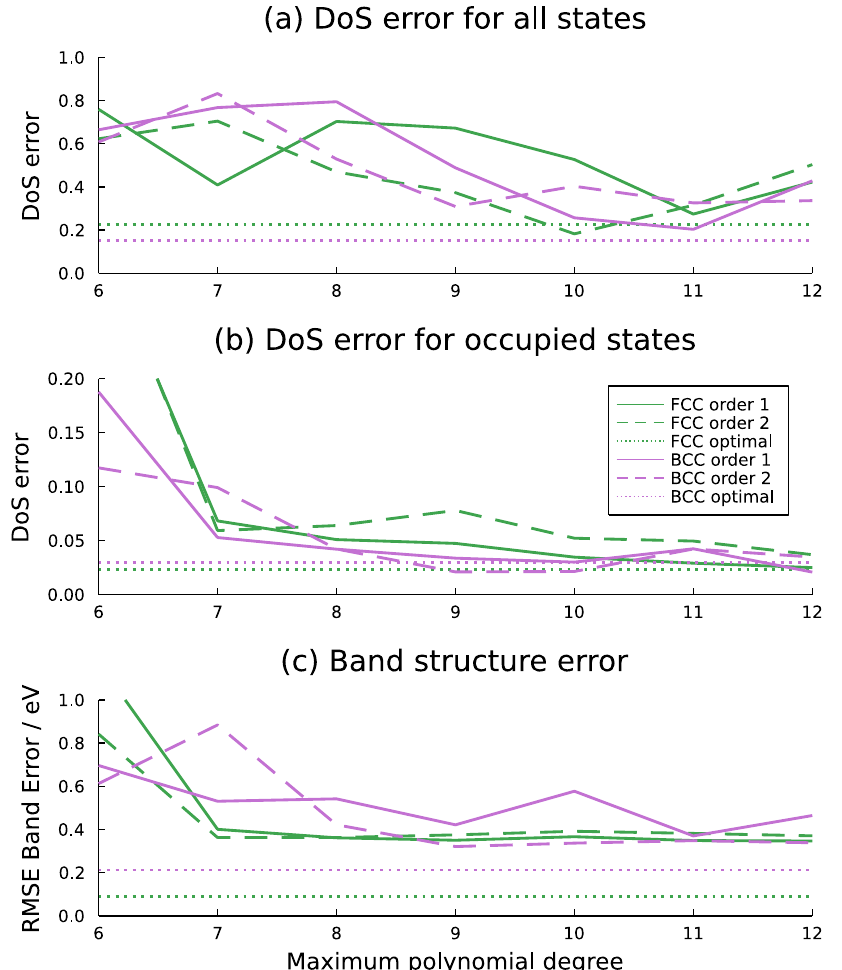
Fig. 6 Convergence of FCC and BCC band structures and DoS with respect to the correlation order ν and maximum polynomial degree d max used in the ACE basis set. Dotted lines show the optimised model of the section DoS. b Error in the occupied states, i.e. those below the Fermi level. c Band error computed with Eq.